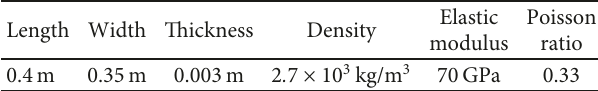
Table 8: Material parameters of face sheets at reference temper- ature (25 ° C).